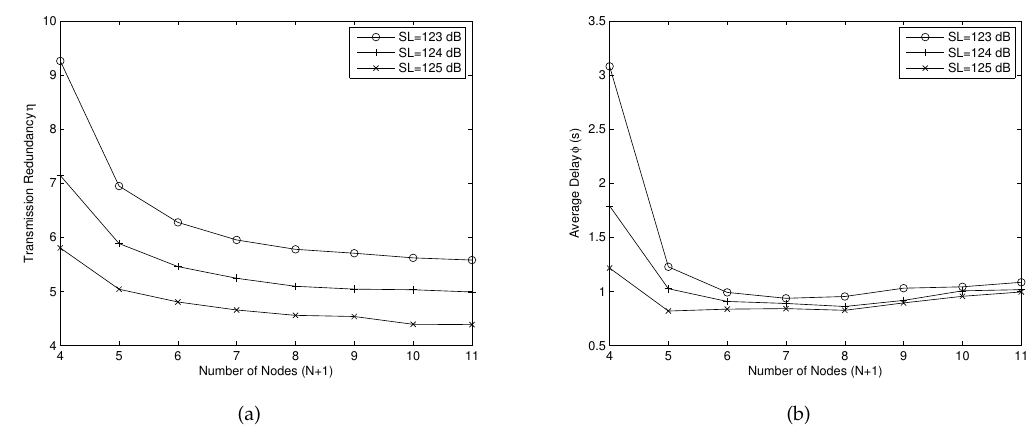
Figure 7. ( a ) the transmission redundancy η for different transmitting sound level SL ; ( b ) the average delay φ for different transmitting sound level SL